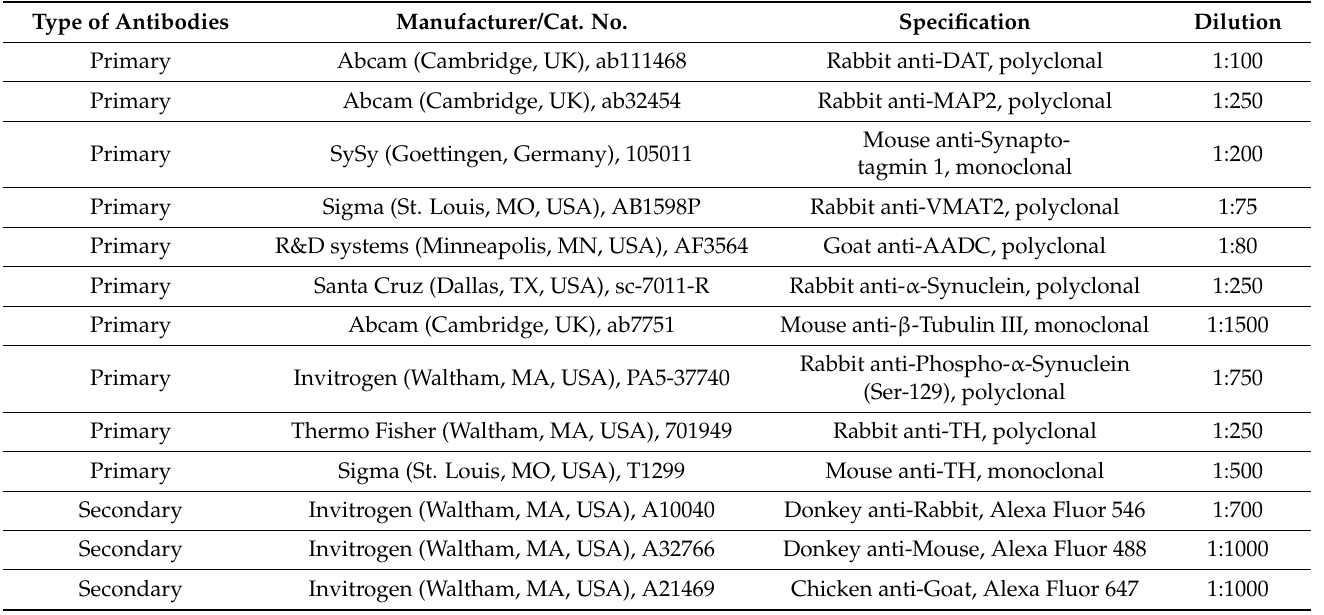
Table 2. Primary and secondary antibodies used for immunostaining of differentiated LUHMES cells. Type of Antibodies Manufacturer/Cat.